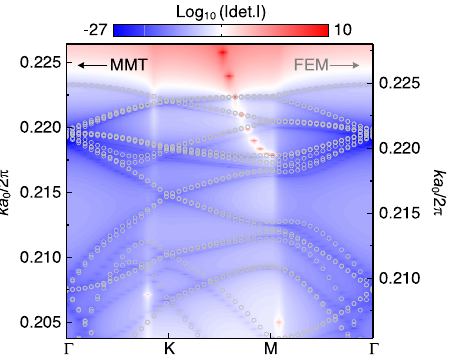
Fig. 5 Comparison between MMT and the FEM calculations. Band diagrams calculated with the MMT (blue lines) and the FEM (gray